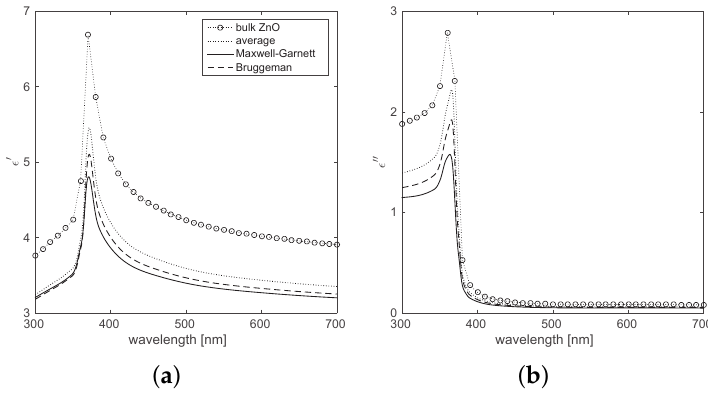
Figure 6. Real (cid:101) (cid:48) ( a ) and imaginary (cid:101) (cid:48)(cid:48) ( b ) parts of the dielectric permittivities. The dotted line with empty circles represent the values of pure ZnO (orientation averaged). The dotted, solid and dashed lines represent the effective permittivities of mesocrystal structure with f = 0.74 volume fraction = 1.33 2 computed by the averaging, Maxwell-Garnett and of ZnO immersed in water with (cid:101) H 2 O Bruggeman